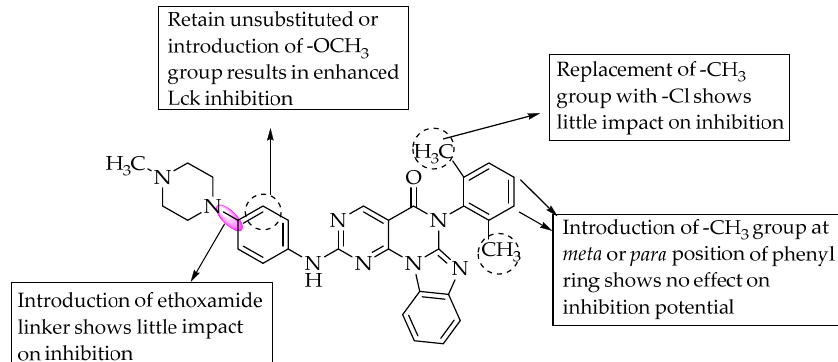
Figure 20. SARs of 2-benzimidazole substituted with pyrimidine.